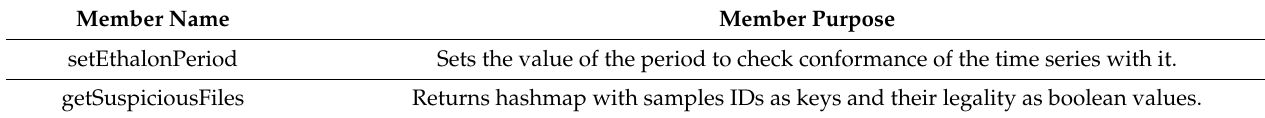
Table A4. Members of PeriodAnalyzer class.